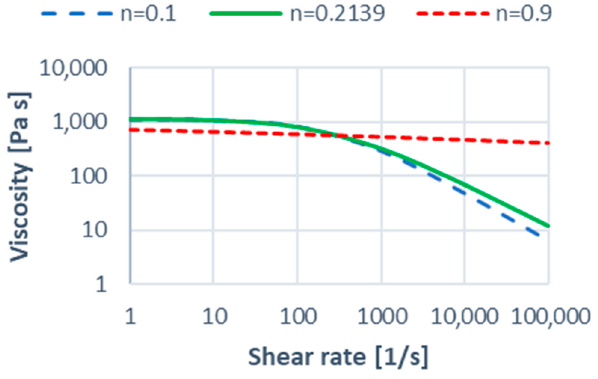
Figure 5. Effect of the power-law index n on the viscosity curve in relation to PBT Valox 337 ( n = 0.2139).